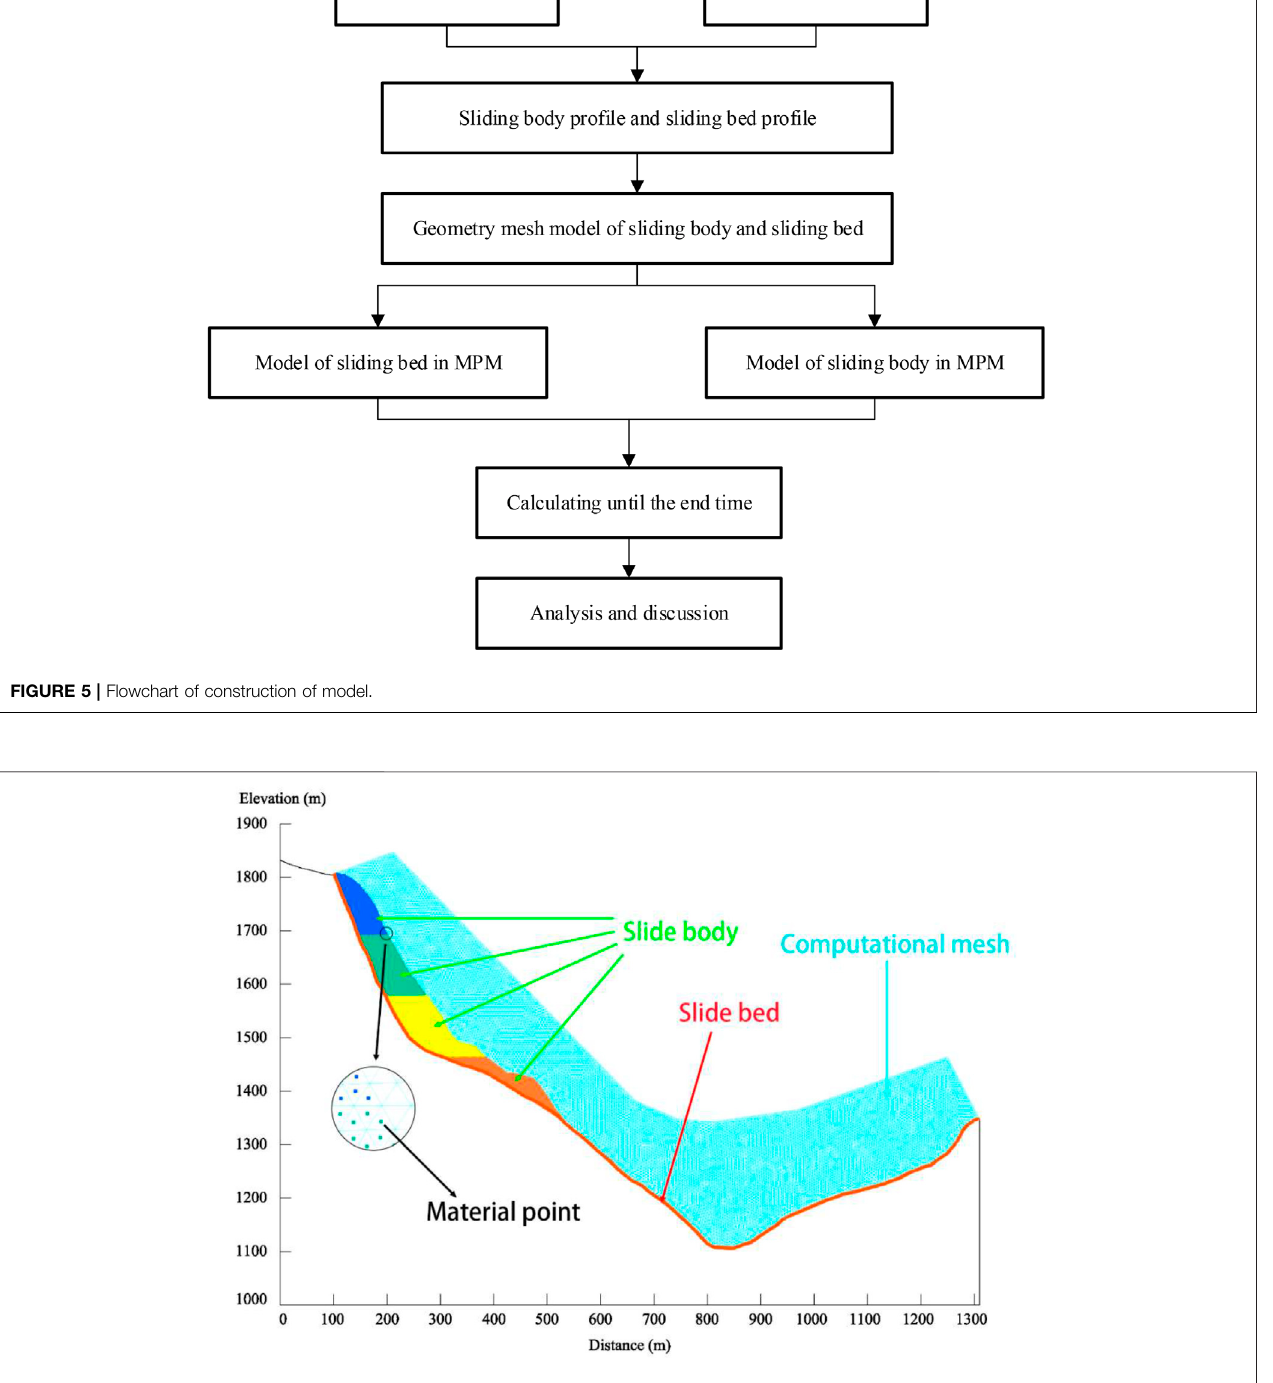
of model as show in Figure 5 . The cross-section B-B ’ in Figure 4B was selected as a reference for model construction in the numerical simulation.